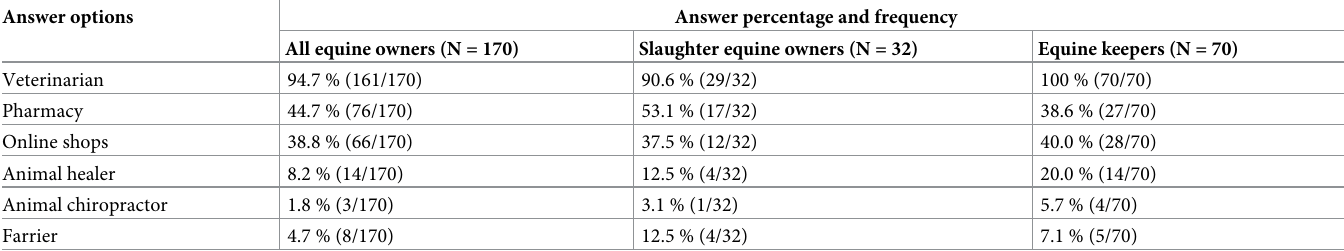
Table 4. Comparison of the drug supply sources of all equine owners, self-classified slaughter-equine owners, and equine